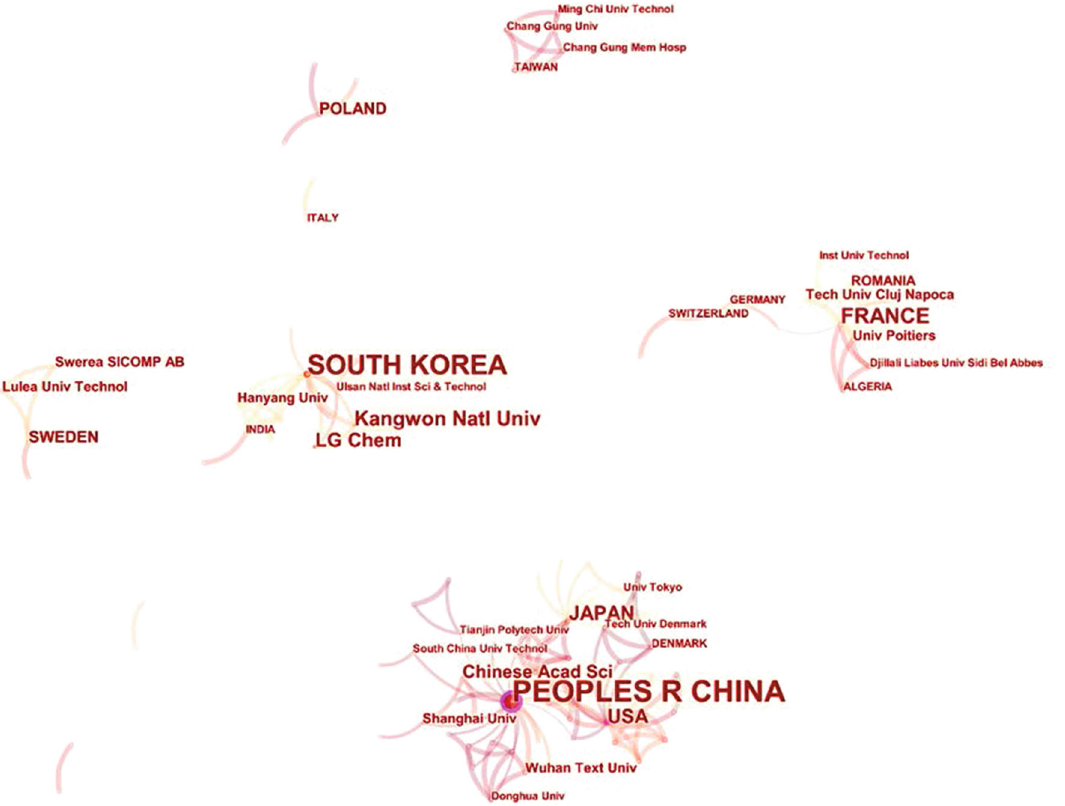
Figure 6: Institution collaboration network map.